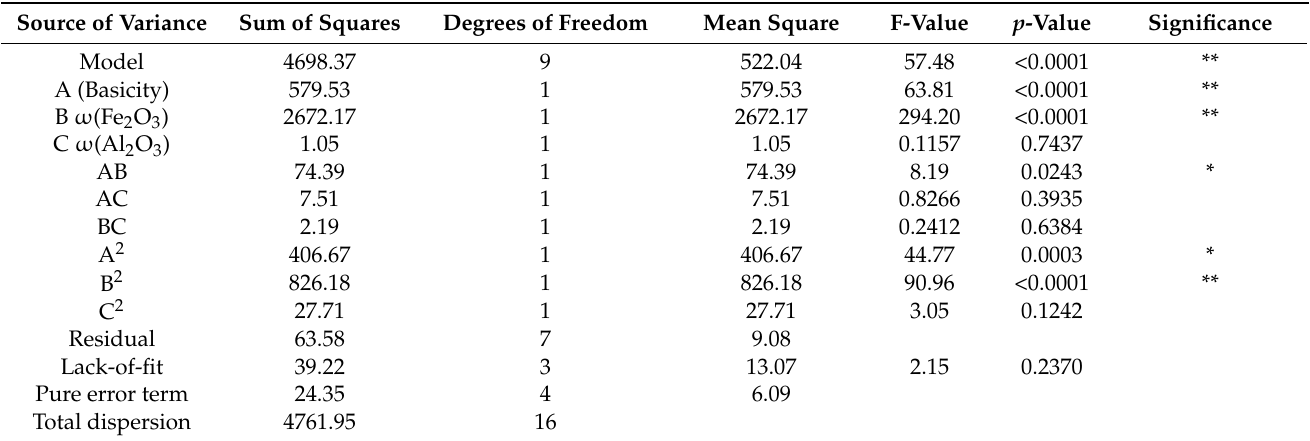
Table 6. Box–Behnken test ANOVA